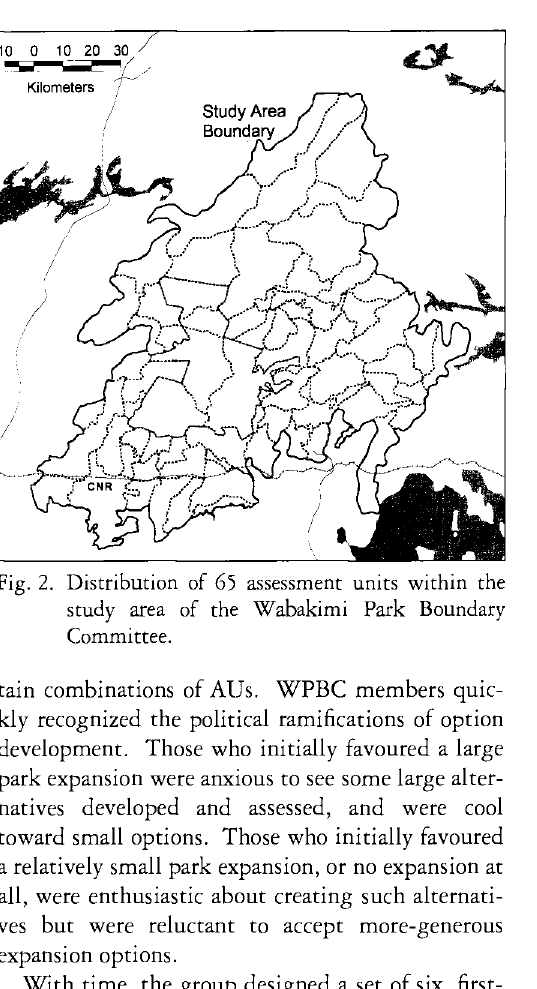
Fig. 2. Distribution of 65 assessment units within the study area of the Wabakimi Park Boundary Committee.